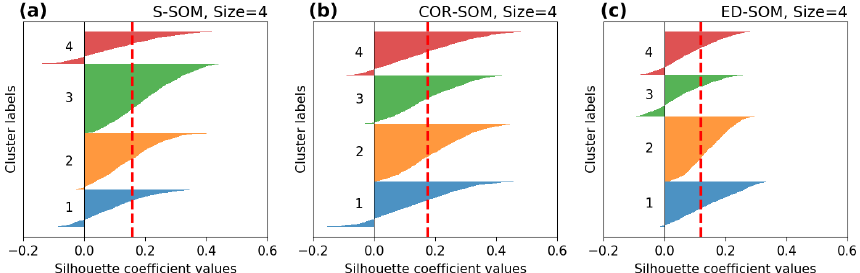
Figure A6. Silhouette plot for S-, COR-, and ED-SOM clustering for summer months (JJA). Note that these are results from simulations with the SOM-node size of 4. The vertical dashed red lines in each plot indicate the silhouette score.